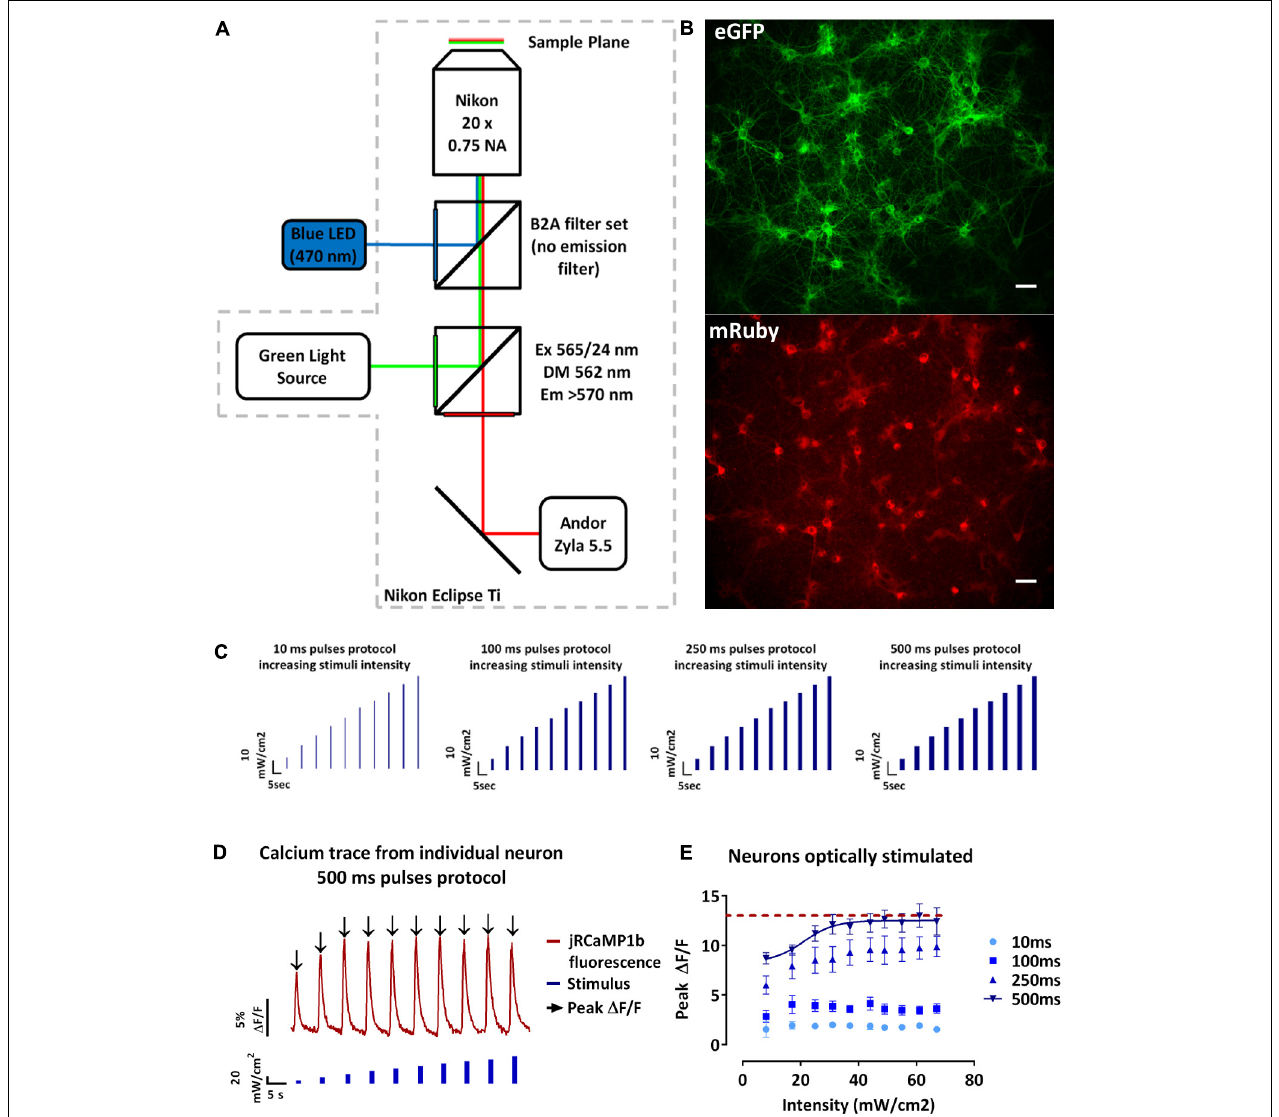
FIGURE 2 | Optical recordings of light evoked-calcium event in neuronal dissociated cultures. (A) Schematic drawing of the imaging setup for all-optical stimulus and readout. The setup is based on a Nikon Eclipse Ti epi-fluorescence microscope mounting a B2A filter set (without the emission filter) for the blue LED illumination (470 nm) and a modified Cy3/TRITC longpass filter set (excitation filter 565/24 nm, dichroic mirror 562 nm, longpass emission filter > 570 nm) for the green light source. Recordings are performed at 10 Hz using a Andor Zyla 5.5 sCMOS Camera. (B) Neuronal dissociated cultures at 14 days in vitro expressing OptoCaMP via lentiviral transduction. CheRiff-eGFP expression in green (eGFP) and mRuby based GECI jRCaMP1b in red (mRuby). Scale bar 100 µ m. (C) Schematic of the temporal optical stimuli protocols which consisted in 10 consecutive pulses of blue light (470 nm) of 10 ms, 100 ms, 250 ms, and 500 ms with increasing steps of 7 mW/cm 2 ± 1 mW/ cm 2 between each pulse (measured at the sample). (D) Typical trace of the fluorescence change of the GECI jRCaMP1b (red trace) of a single-neuron during the 500 ms pulses protocol of increasing blue stimulation intensities (0 to 67mW/cm 2 ). From this trace we can then extract the peak fluorescence (cid:49) F/F (black arrow) for each stimulus intensity for individual neurons of the field of view simultaneously. (E) Amplitude of the calcium events in response to increasing stimuli intensities and pulse duration of 10, 100, 250, and 500 ms. The peak fluorescence from individual neuron at each stimuli intensity was averaged to obtain mean ± s.e.m. values ( n = 3, two-way ANOVA, effect of the stimulus intensity F (9,560) = 41.80, P < 0.0001, effect of the stimulation duration F (3,560) = 4470, P < 0.0001 followed by Tukey’s multiple comparisons test showing a plateau (red dashed line) for 500 ms pulses protocol, stimulus above 25 mW/cm 2